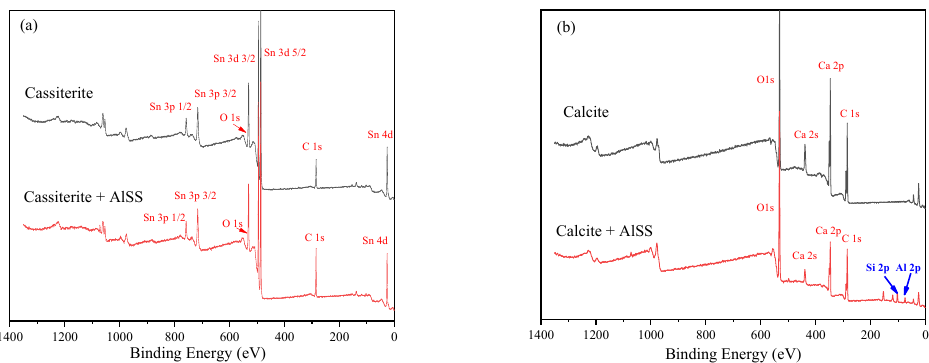
Figure 13. Survey scan XPS spectra of cassiterite ( a ) and calcite ( b ) before and after AlSS treatment. Figure 14 demonstrates the precise scan of Sn 3d core peaks and Ca 2p/2s core peaks on the cassiterite and calcite surface before and after being treated by AlSS. Generally speaking, the change of binding energy in the range of 0.2 eV may be caused by detection error. For a chemical reaction, the change of binding energy of metal elements on the mineral surface will be higher than 0.2 eV [29]. As shown in Figure 13a, in natural conditions, the binding energies of Sn 3d5/2 and Sn 3d3/2 in the spectrum of cassiterite are 486.27 eV and 494.65 eV, respectively. After being treated by AlSS, the binding energies of Sn 3d5/2 and Sn 3d3/2 are shifted to 486.16 eV and 494.60 eV, respectively. Because the peak shifts for Sn 3d5/2 and Sn 3d3/2 are very small (less than 0.2 eV), it can be inferred that the chemical environment of cassiterite surface is not changed by the addition of AlSS. For calcite, in the natural condition, the binding energies of Ca 2p and Ca 2s are 347.05 eV and 350.53 eV and shift to 347.37 eV and 350.75 eV, respectively, after being treated with AlSS. Because the change of binding energy of Ca 2p and Ca 2s on the calcite surface after AlSS treatment is 0.32 eV and 0.22 eV, respectively, it can be inferred that the adsorption of AlSS leads to the change of chemical environment on the calcite surface.